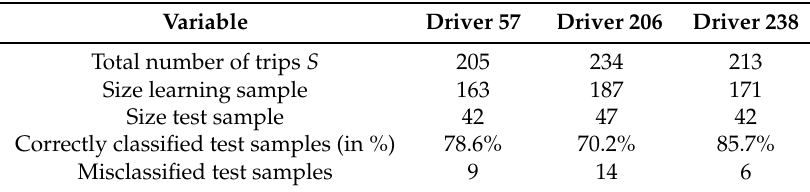
Table 1. Out-of-sample analysis of drivers 57, 206 and